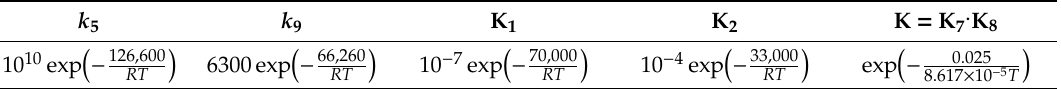
Table 2. Values of the parameters estimated by fitting the reaction rates with Equations (17) and (18). k 5 k 9 K 1 K 2 K = K 7. K 8 (cid:17) (cid:16) (cid:17) (cid:16) (cid:17) (cid:16) (cid:17) (cid:16) (cid:16) − 66,260 − 70,000 − 33,000 − 126,600 6300exp 10 − 7 exp 10 − 4 exp exp 10 10 exp RT RT RT RT